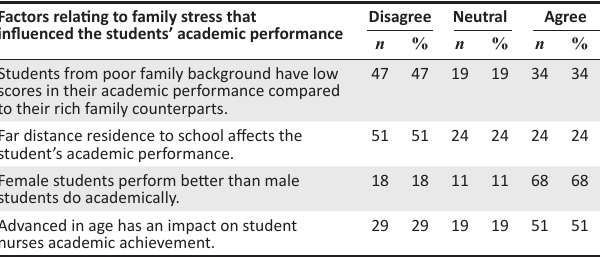
n , number of respondents. TABLE 4: Student nurses’ perceptions of factors relating to family stress that influenced their academic performance. Factors relating to family stress that influenced the students’ academic